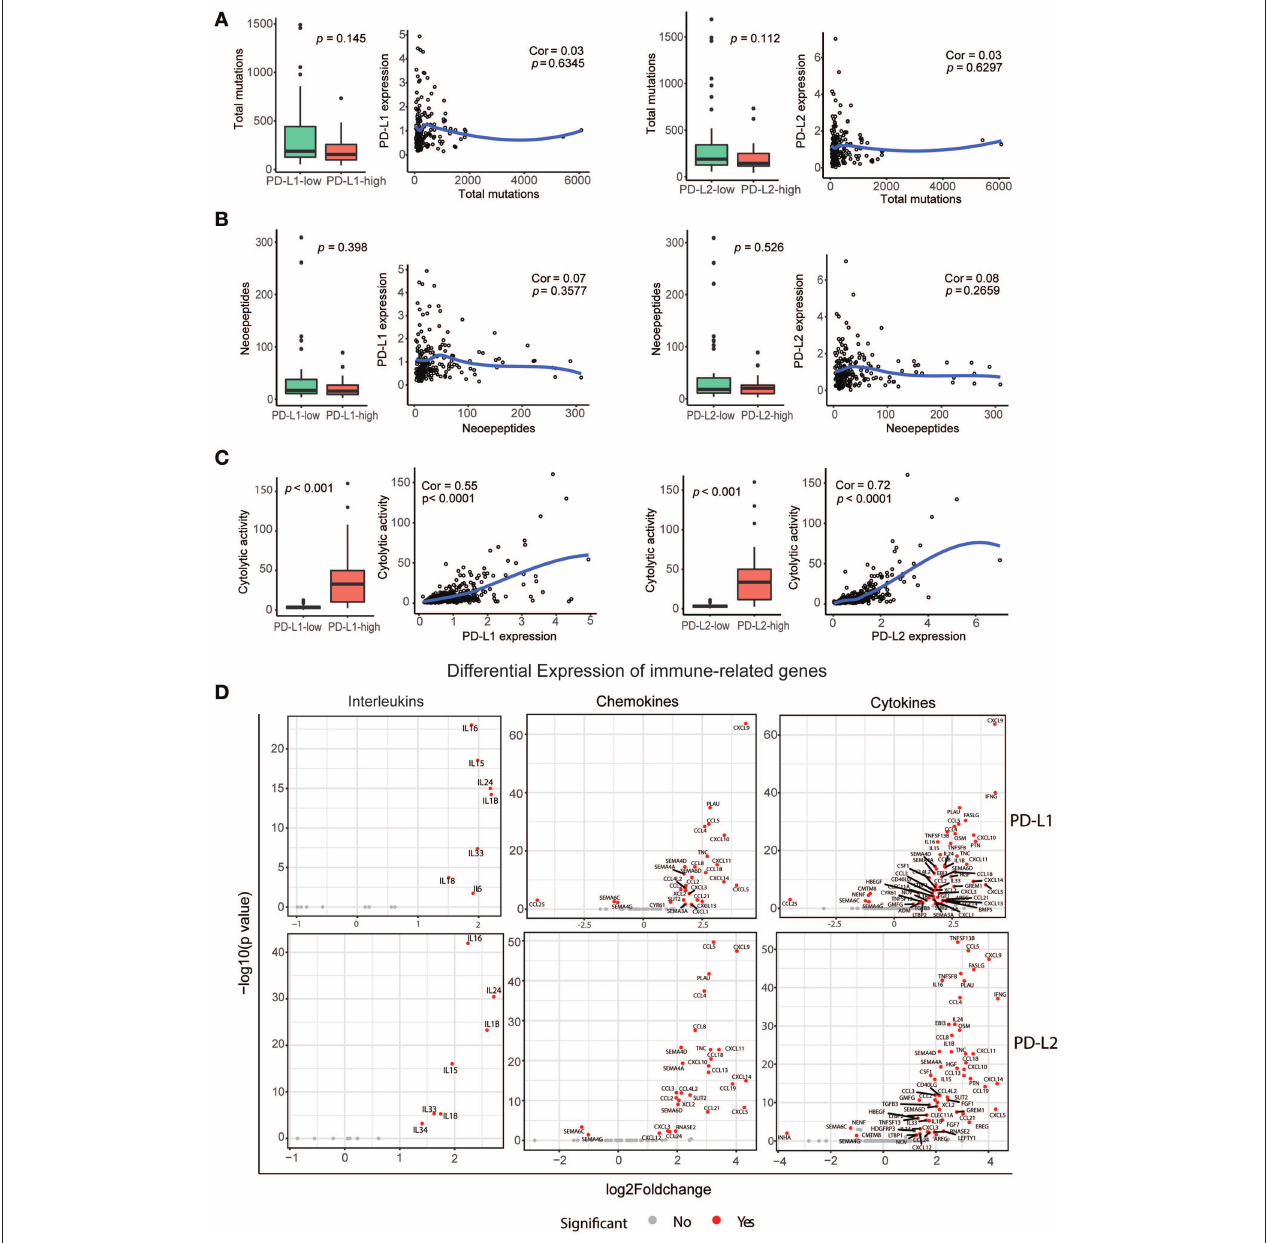
FIGURE 6 | Correlation between PD-Ls and neoepitope loads, cytolytic activity, and immune gene expression. (A) Local regression curves (Spearman rank correlation) between expression of PD-Ls and total mutation count; boxplot distributions between HCC subsets stratified by the expression of PD-Ls (Mann-Whitney). (B) Local regression curves between the expression of PD-Ls and numbers of neoepitopes and boxplot distributions between HCC subsets stratified by the expression of PD-Ls. (C) Local regression curves between the expression of PD-Ls and cytolytic activity and boxplot distributions between HCC subsets stratified by PD-Ls expression. (D) Differentially expressed cytokines between PD-Ls-high and -low HCC samples.